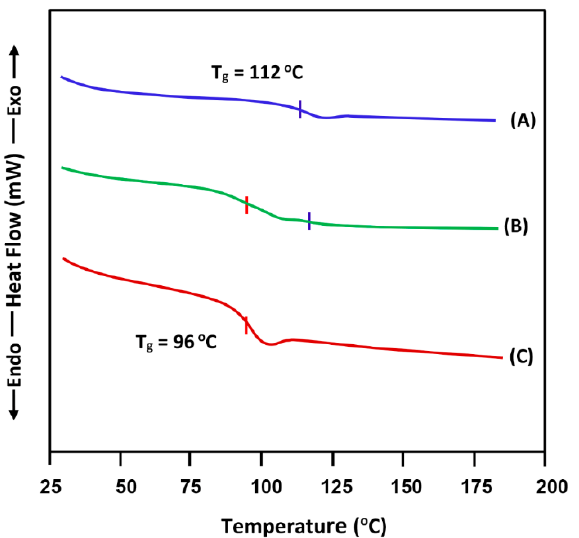
Figure 1. DSC thermograms of: (A) pure PMMA; (B) PS/PMMA-50 blend and (C) pure PS. (B) Miscibility of PS/PVC-50